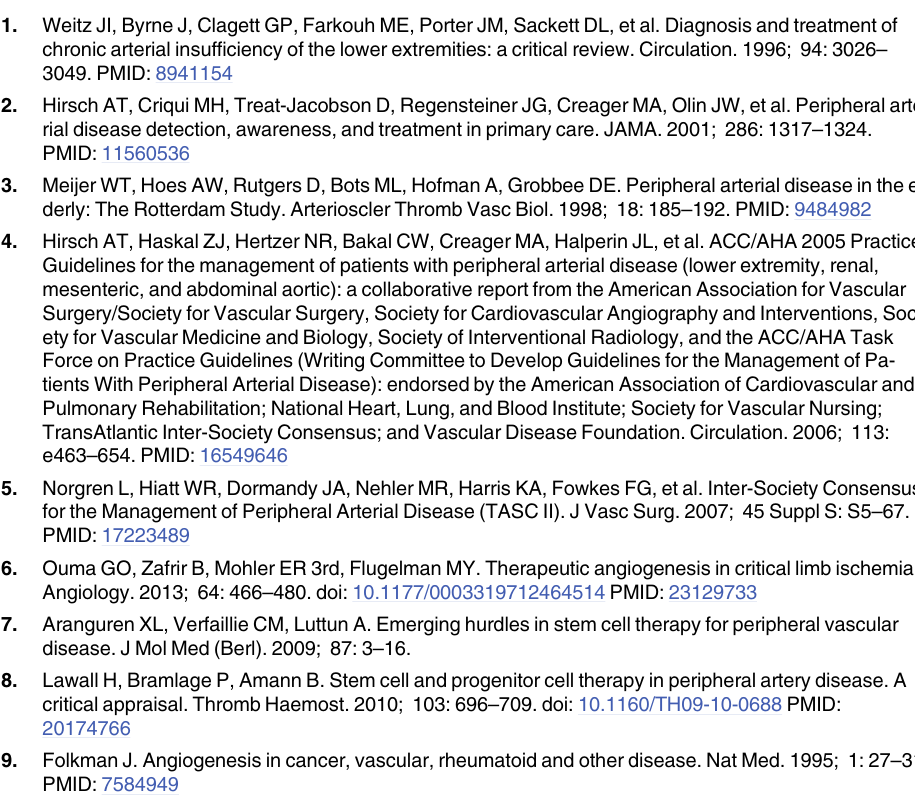
S1 Fig. Effects of anti-VEGFA, PDGFB and bFGF antibodies on migration and prolifera- tion of HUVECs and HASMCs induced by 2HP- β -CD. Figure A: HUVECs were treated with/without 10 ng/ml anti-VEGFA, PDGFB and bFGF antibodies, and HASMCs were treated with/without 1 ng/ml anti-VEGFA, PDGFB and bFGF antibodies followed by incubation with/without 10 – 8 M 2HP- β -CD for 72 h. Data represent the mean ± S.E.M. (n = 3 experi- ments). (cid:2) p < 0.05, (cid:2)(cid:2) p < 0.01, vs. 10 – 8 M 2HP- β -CD group. Figure B: HUVECs were treated with/without 10 ng/ml anti-VEGFA antibody, 1 ng/ml anti-PDGFB antibody, and HASMCs were treated with/without 1 ng/ml anti-bFGF antibody followed by incubation with/without 10 – 8 M 2HP- β -CD for 5 h. Data represent the mean ± S.E.M. (n = 3 experiments). (cid:2) p < 0.05, (cid:2)(cid:2) p < 0.01, vs. 10 – 8 M 2HP- β -CD